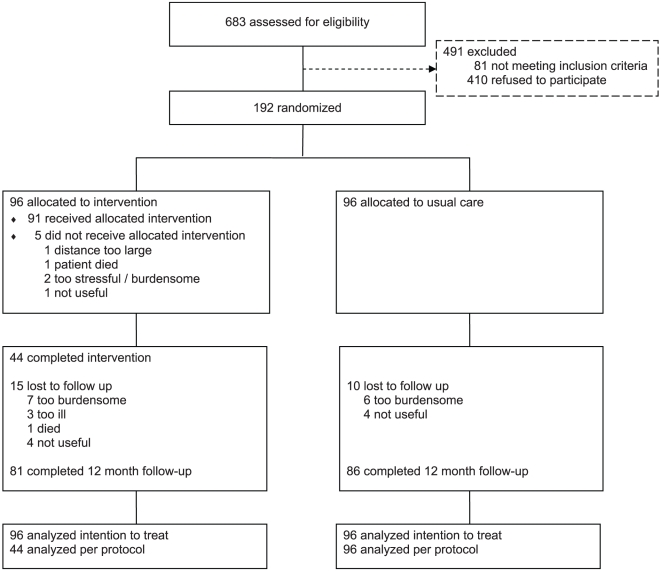
Flow diagram of the study sample.